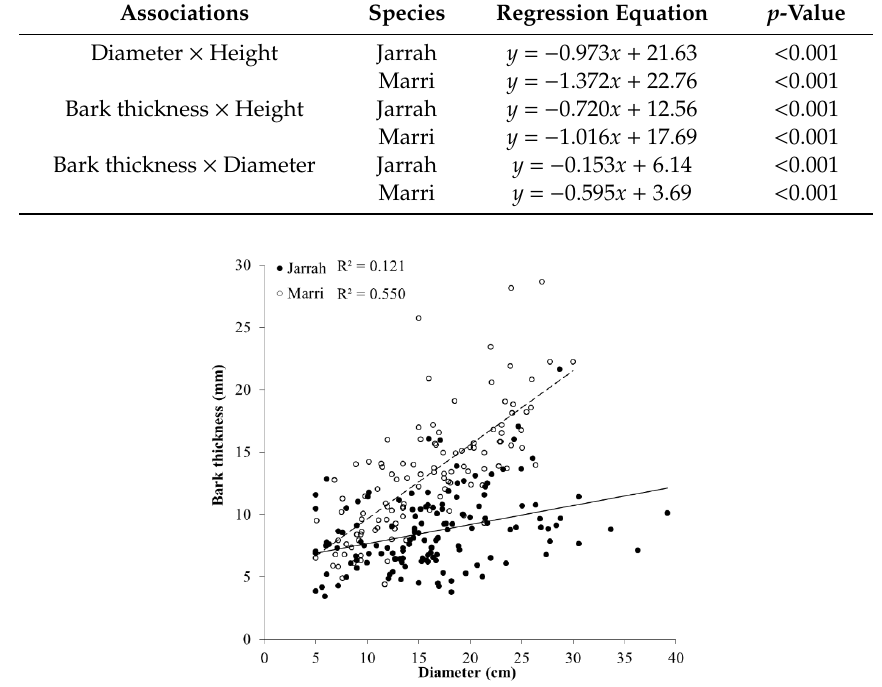
) ( n = 114) trees (cid:35)